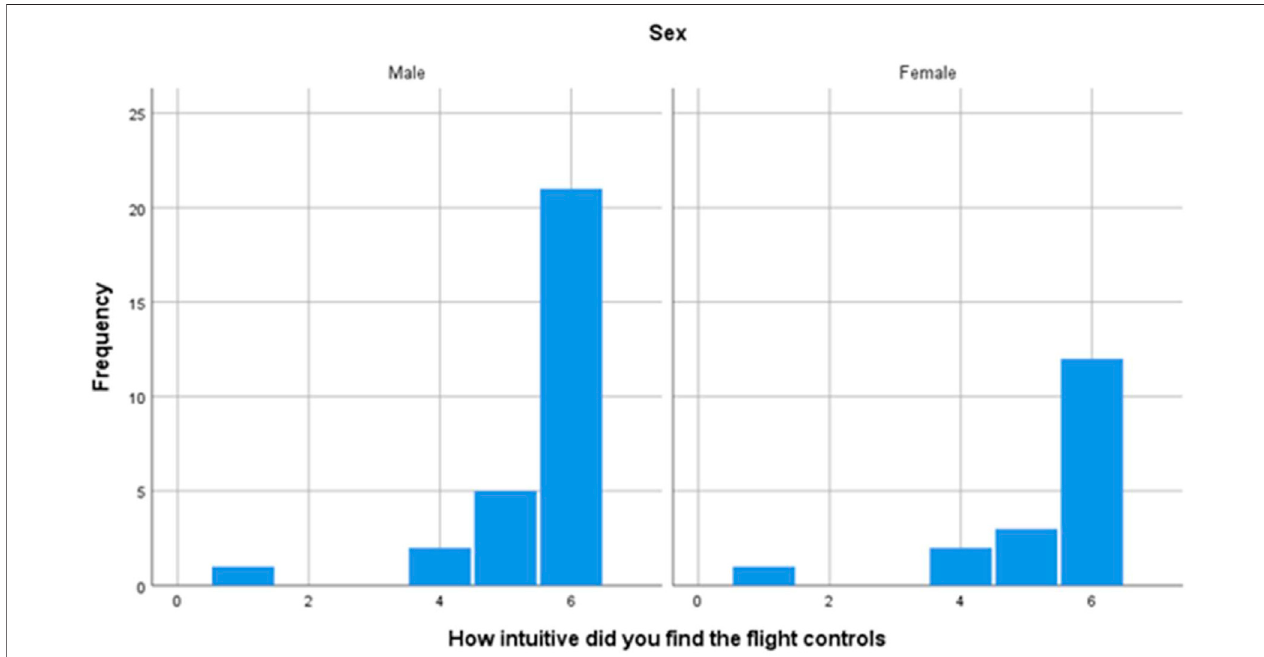
FIGURE 9 | Questionnaire participants results for how intuitive they found the controls for fl ying the drone.